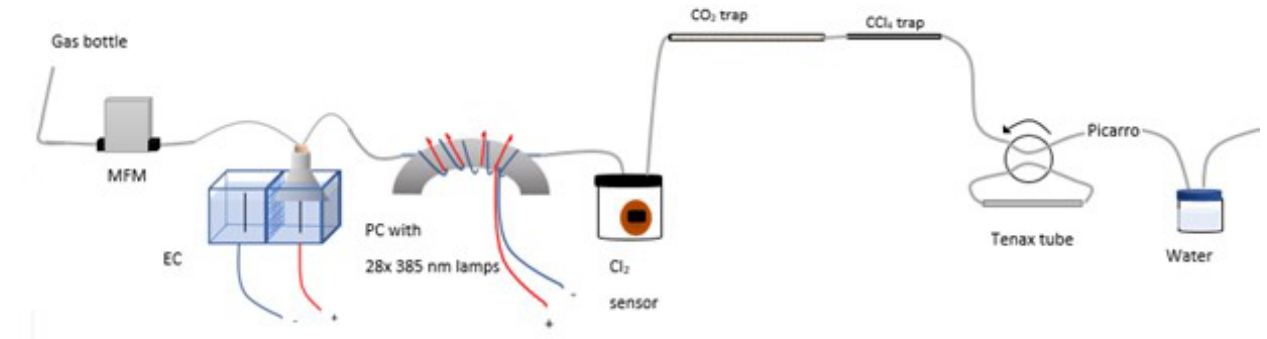
Figure A1. Experimental setup B2 with the inclusion of an activated carbon trap. Gas flask: ambient air sample, MFM: mass flowmeter, EC: electrolytic device, PC: photochemical